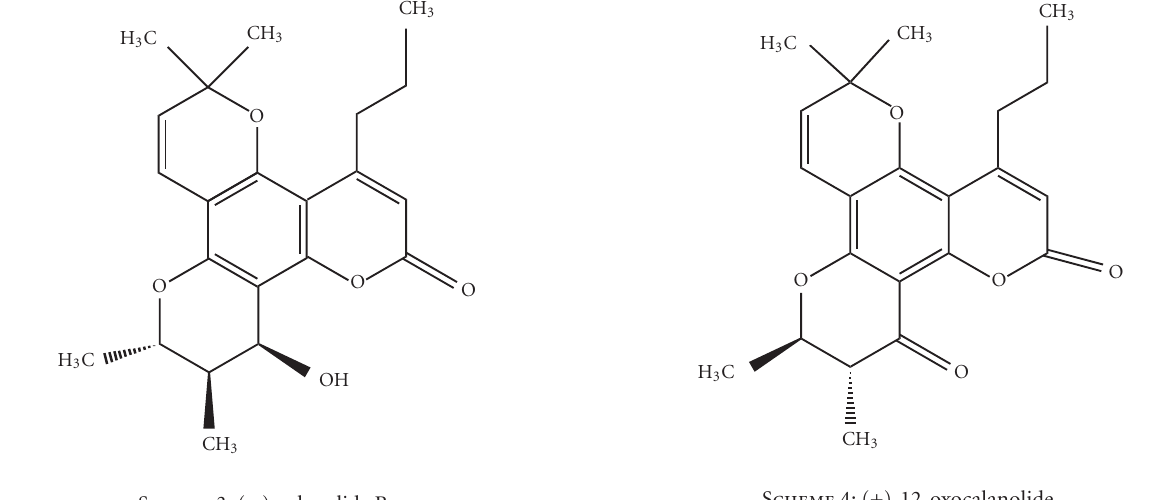
Scheme 3: ( − )-calanolide B. Scheme 4: